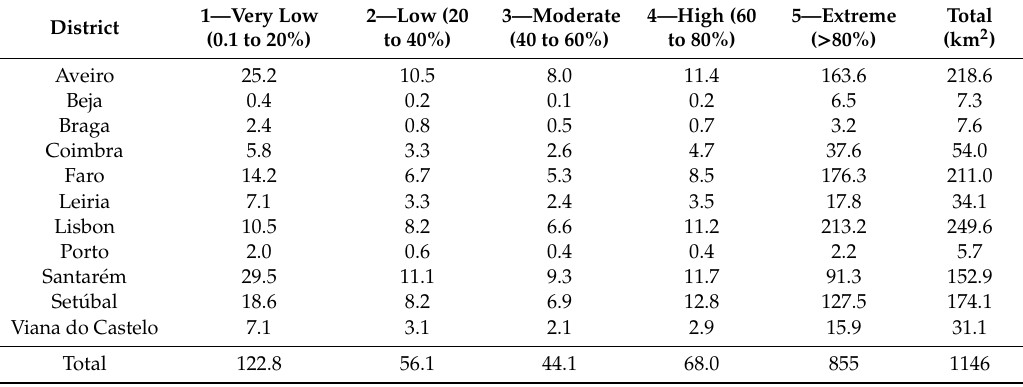
Table 8. Flooding areas (in km 2 ) for each EFHI class interval and respective probability, for the SLR 2100 scenario in each coastal